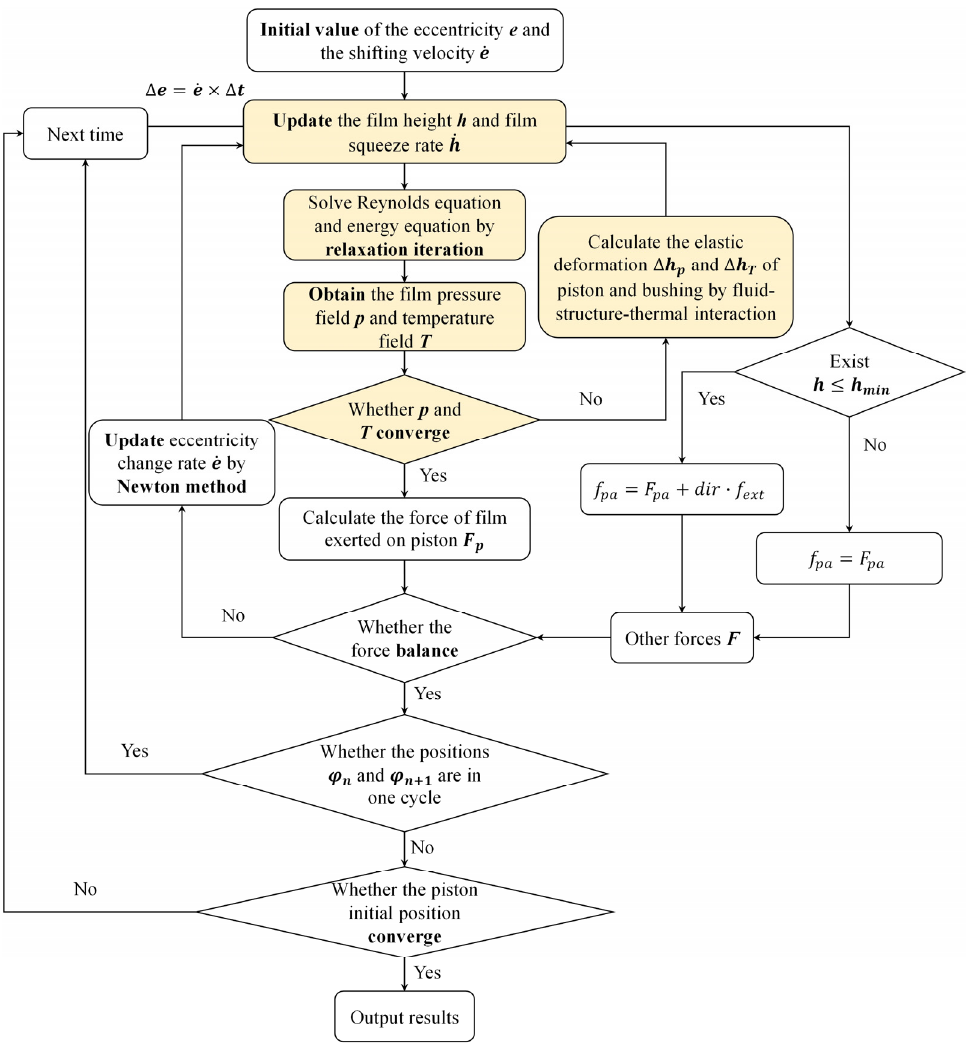
Figure 10. Calculation process.